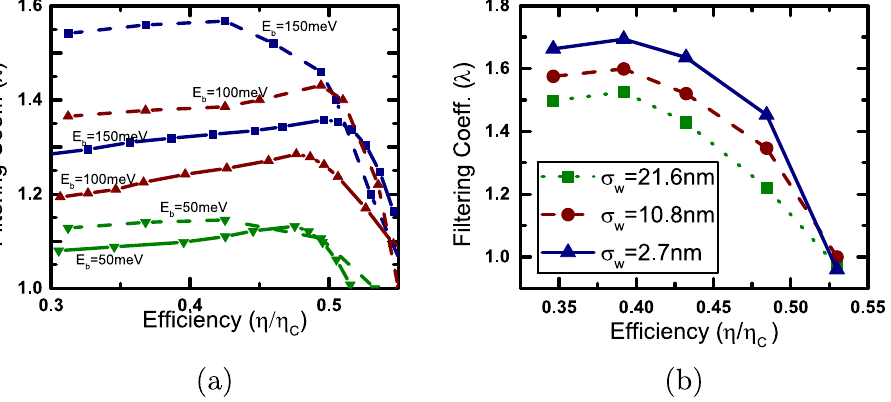
Figure 5. Demonstration of the optimum conditions under which energy filtering should be employed. ( a ) Demonstration of the enhancement in the filtering coefficient when the total length of the generator is much greater than the width of the energy filtering barrier. Plot of the filtering coefficient ( λ ) versus efficiency ( η / η C ) for various barrier heights in case of 2.7 nm wide square nanowires of length 20 nm (solid curves) and 40 nm (dashed curves). The nanowires are embedded with a Gaussian energy barrier ( σ w = 2.7 nm ). ( b ) Demonstration of deterioration of filtering coefficient when the width of the energy barrier is increased compared to the minimum width necessary to block an appreciable reverse flow of electrons from the cold contact. Filtering coefficient versus efficiency ( η / η C ) for a 170 nm long diffusive nanowire with different energy barrier widths (with E b = 150 meV ) taking acoustic phonon scattering into